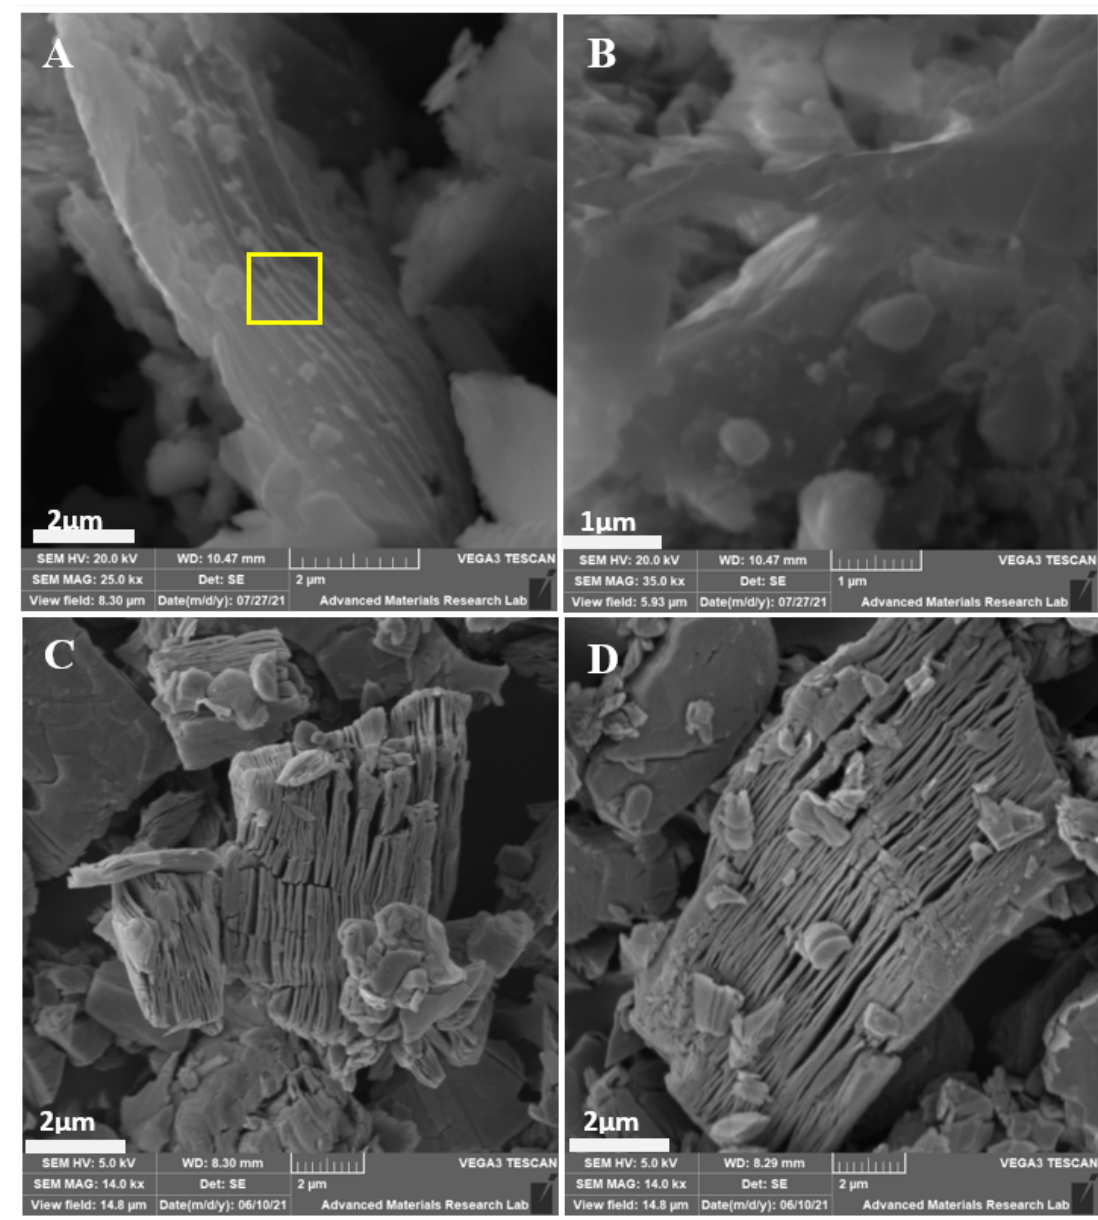
Figure 4. ( A ) SEM side view image of the Ti 3 AlC 2 sheets; ( B ) SEM top view image of Ti 3 AlC 2 sheets; ( C , D ) SEM side view image of Ti 3 C 2 T x .